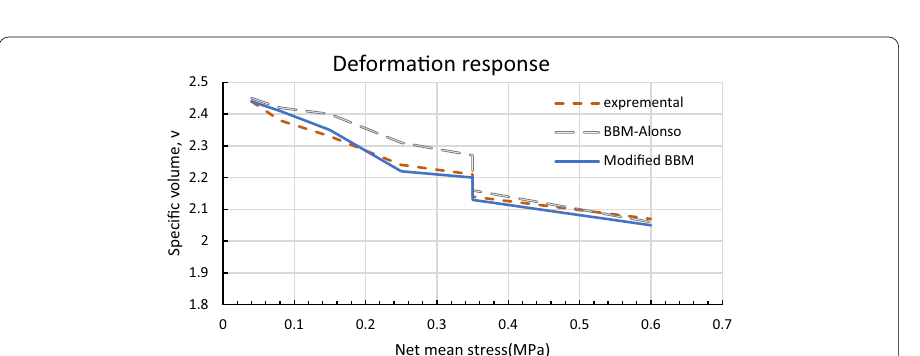
Fig. 18 Comparison among measured, predicted and modified model results for stress path ABFH